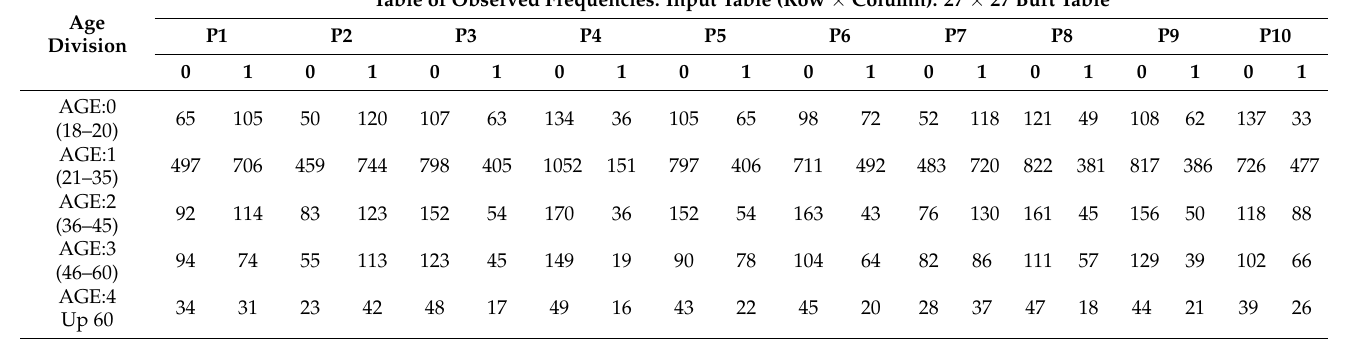
Table 4. The principles of prosumption that were not selected (symbol 0) and selected (symbol 1) by respondents divided by age. Table of Observed Frequencies. Input Table (Row × Column): 27 × 27 Burt